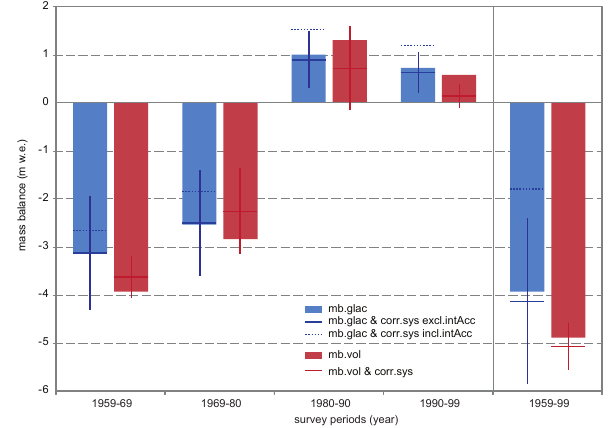
Fig. 2. Decadal glaciological and volumetric mass balances of Stor- glaci¨aren. The “official” glaciological mass balances by Holmlund et al. (2005; blue bars) and the volumetric mass balances by Koblet et al. (2010; red bars) are shown for the periods of the aerial surveys. Corrections for systematic and stochastic uncertainties are indicated by horizontal and vertical lines, respectively. For the glaciological mass balances, the systematic uncertainties including corrections for internal accumulation (intAcc) are shown by dotted horizontal